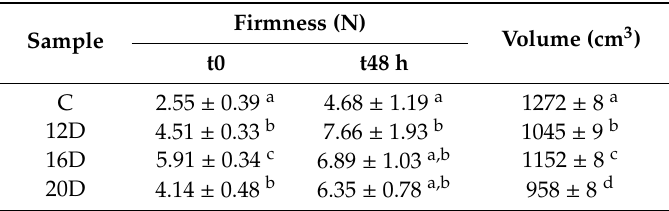
Table 3. Values of crumb firmness and volume obtained for breads. C: control bread without whey; 12D: bread with 12% whey; 16D: bread with 16% whey; 20D: bread with 20% whey. Di ff erent letters (a, b, c, d) in the same column correspond to significant di ff erences (one-way ANOVA, p < 0.05).